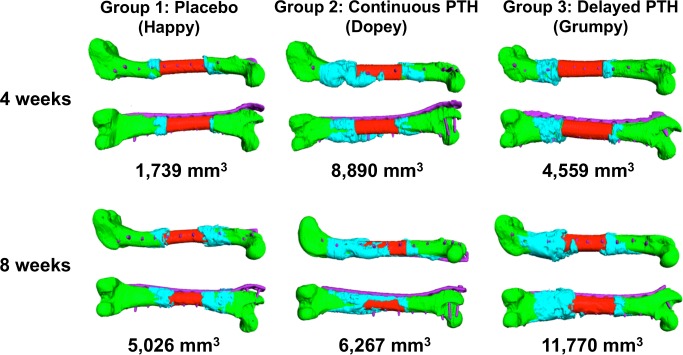
Volumetric CB-CT assessment of callus bone volume.Volumetric rendering of the CB-CT data was performed as described in Materials and Methods, and representative 3D reconstructed images of the plate (purple), host bone (green), allograft (red) and calcified callus (turquoise) of the median dog in each group are shown at 4 and 8-weeks post-op. Of note are: the minimal callus that forms at the graft-host junction in Placebo, the robust new bone formation at 4-weeks that remodels to bridging callus from Continuous PTH at 8-weeks, and the large unremodeled callus at the graft-host junction for Delayed PTH.